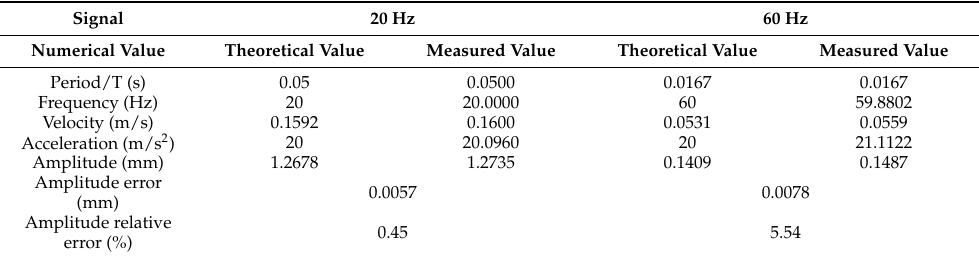
Table 2. Error analysis table of vibration